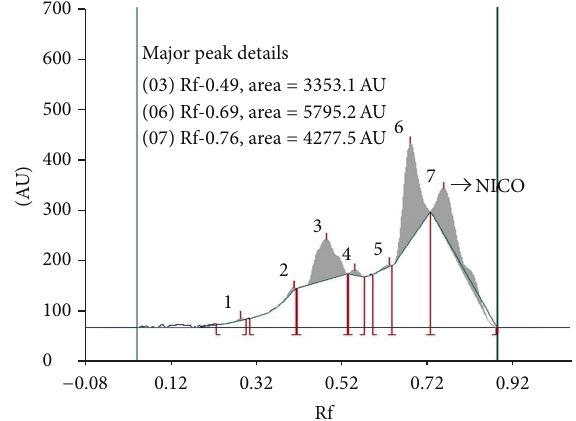
Figure 2: Chromatogram showing the HPTLC profiling of petrole- um ether leaf extract of T. leucostaphylum (AU—Absorbance units; Rf—Retardation factor; NICO—Nicotine).